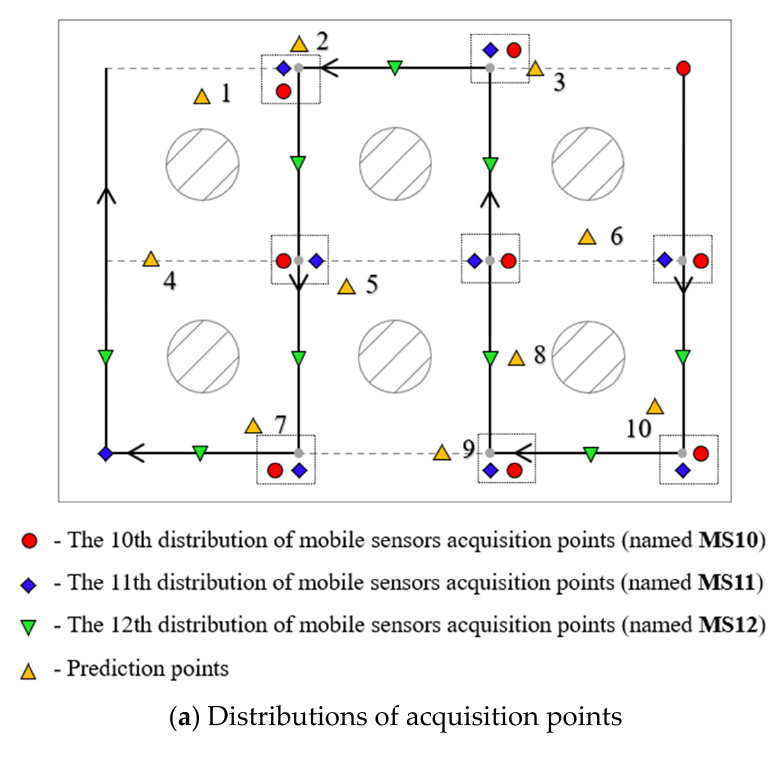
Figure 13. Prediction of mobile sensors with acquisition distance of 3.0 m.